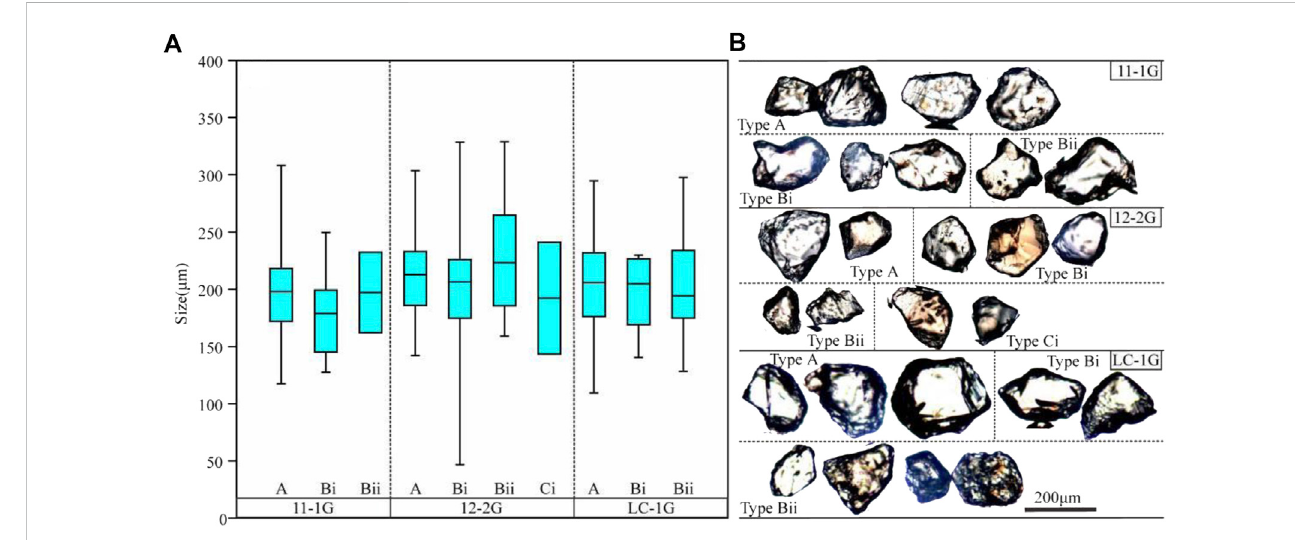
FIGURE 11 Detrital garnet type and its grain size (A) and morphological characteristics (B)